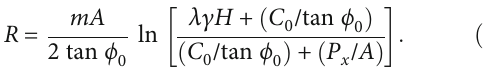
Figure 8: Deformation curve of surrounding rock of coal pillar with di ff erent